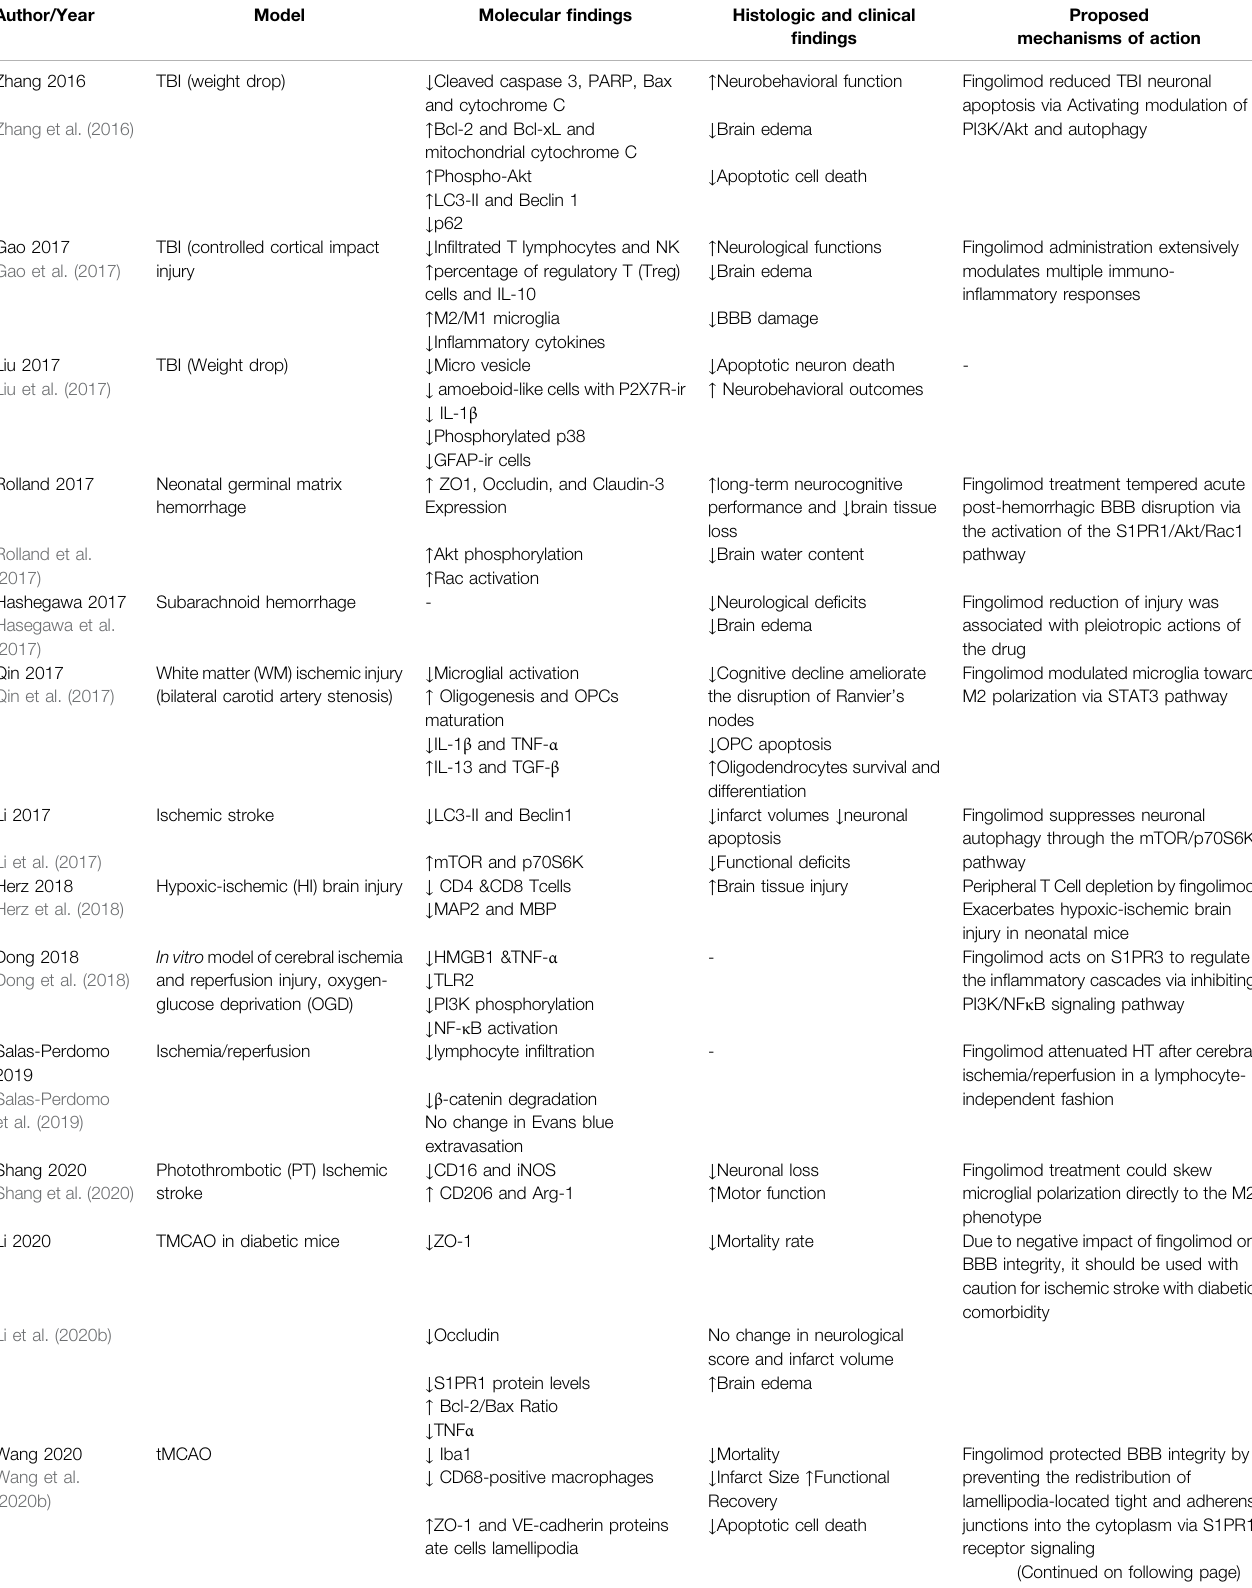
TABLE 3 | ( Continued ) Summary of studies evaluating the effect of fi ngolimod in brain